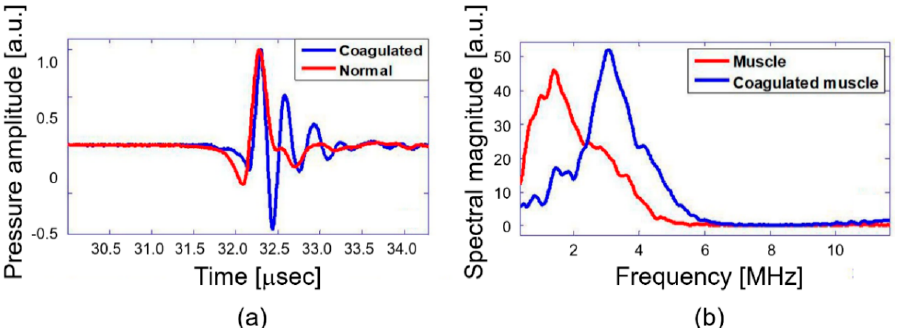
Figure 3. Chicken muscle tissue normal and coagulated: ( a ) photoacoustic (PA) response and ( b ) PA frequency spectrum.